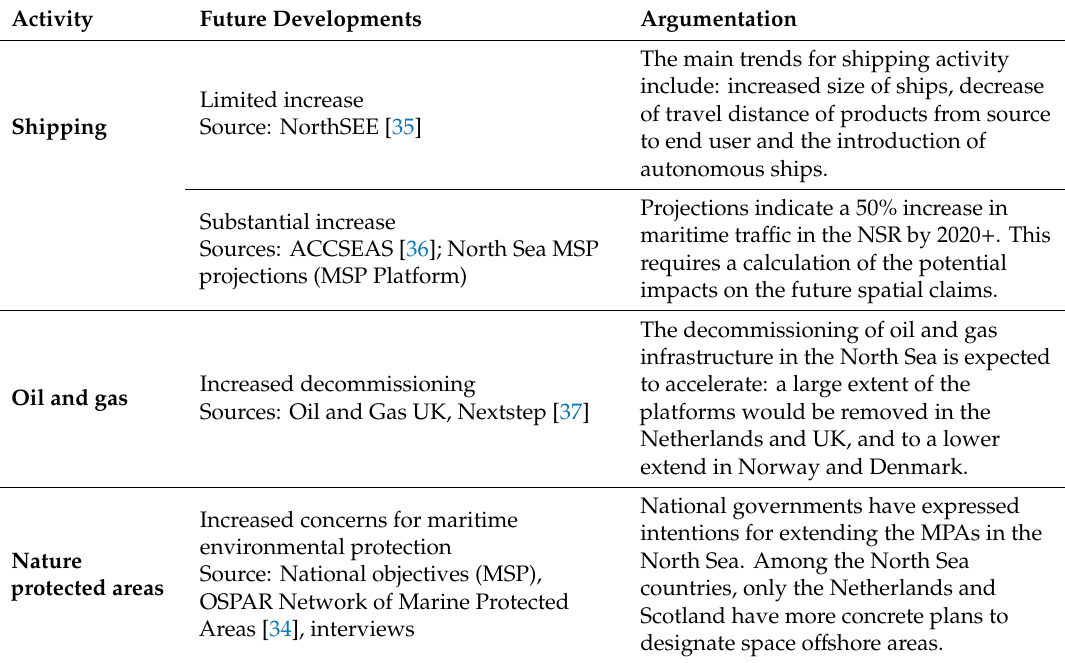
Table 4. Potential future spatial claims (external context)—implications for the scenario